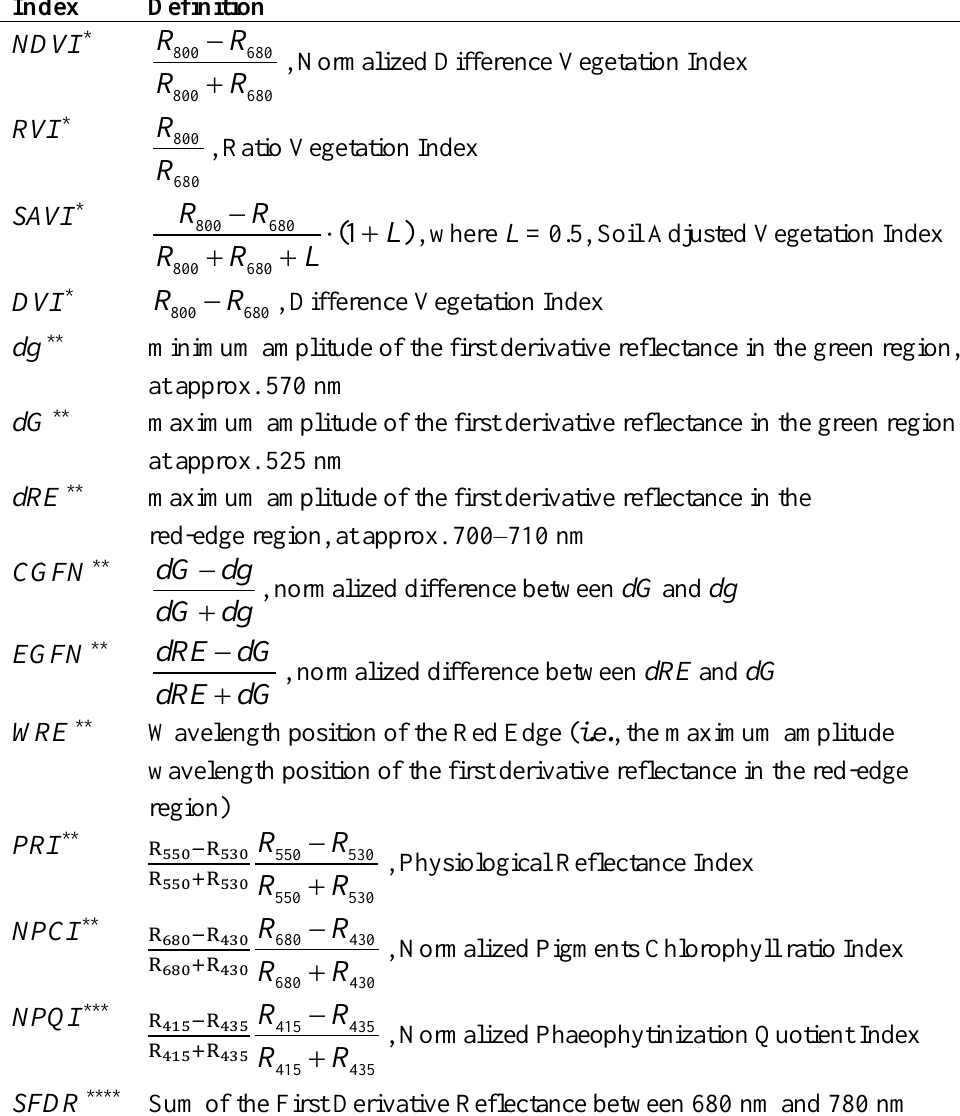
Table 3. Spectral indices used for crop injury